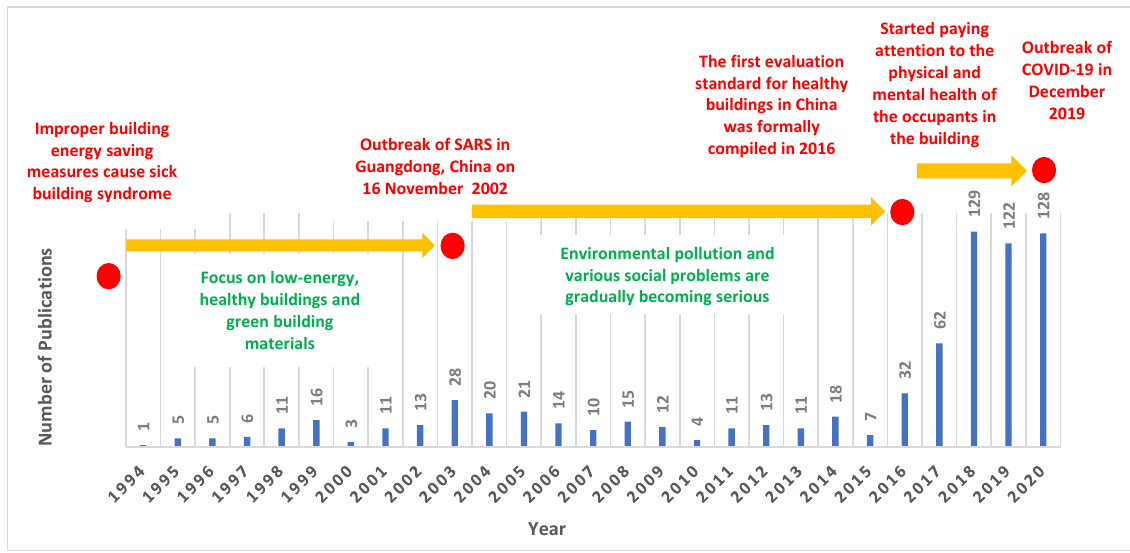
Figure 4. Variation trend on the number of papers published related to healthy buildings in China. Table 3. Milestones of healthy building development in China.